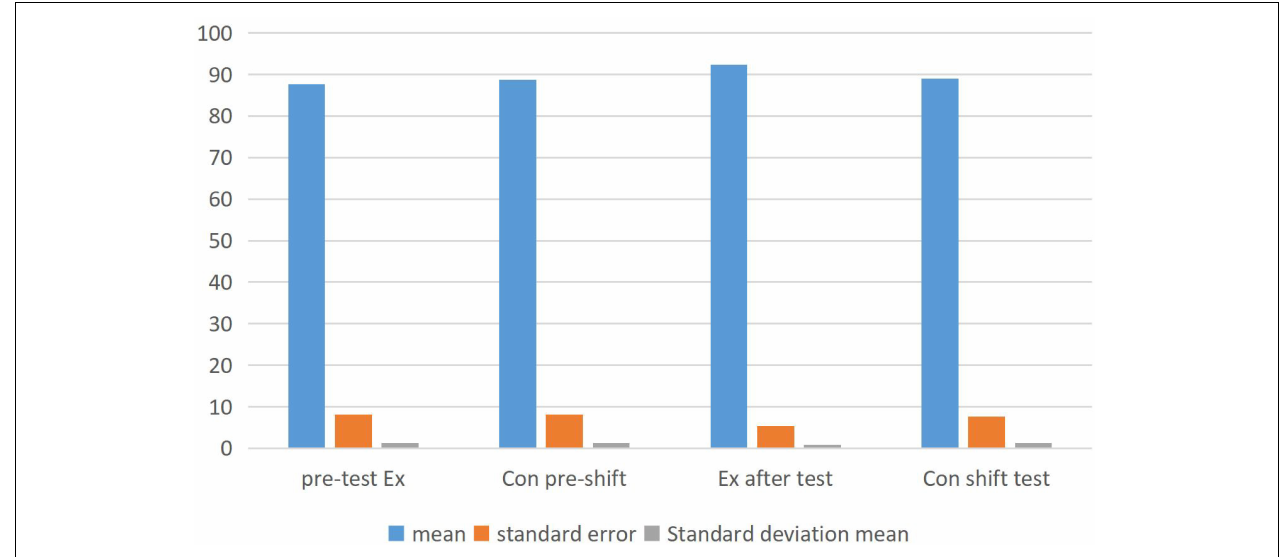
FIGURE 4 | Comparison of sample statistics between experimental and control classes.